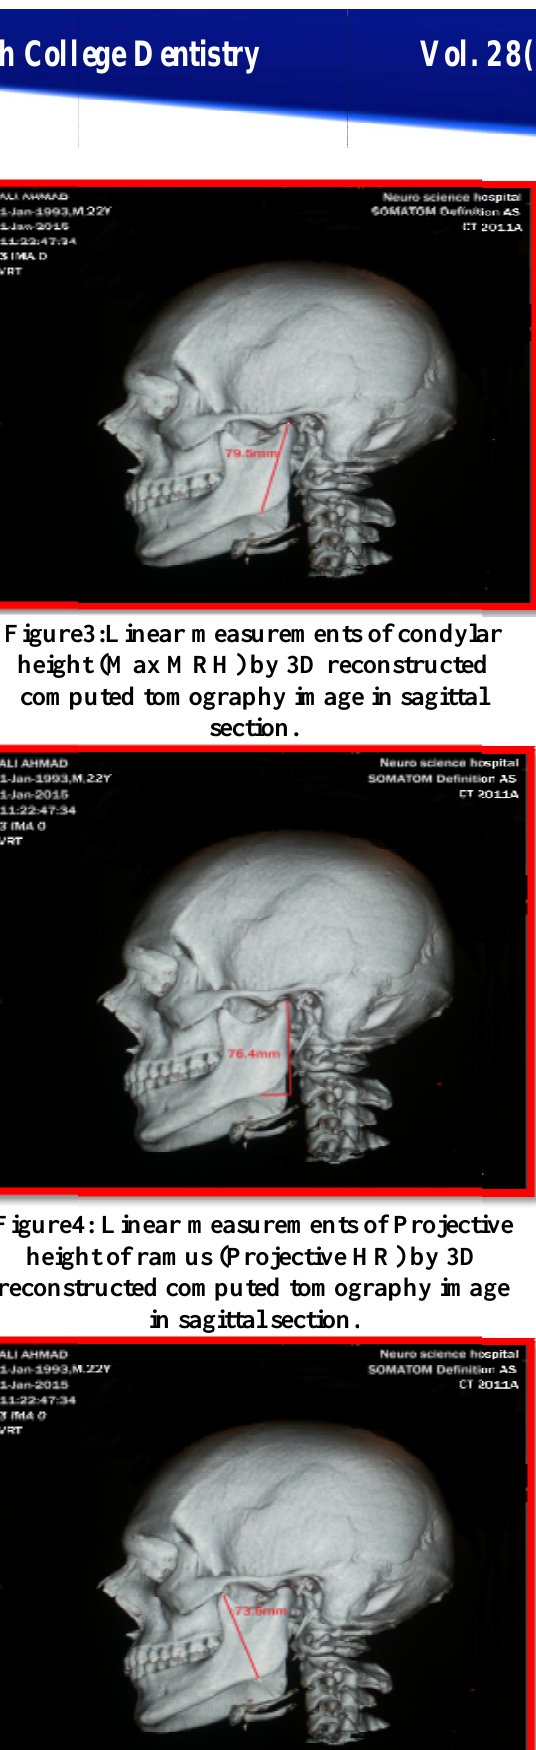
Figure 5: Linear measurements of coronoid hight of ramus(CH) by 3D reconstructed computed tomography image in sagittal section.